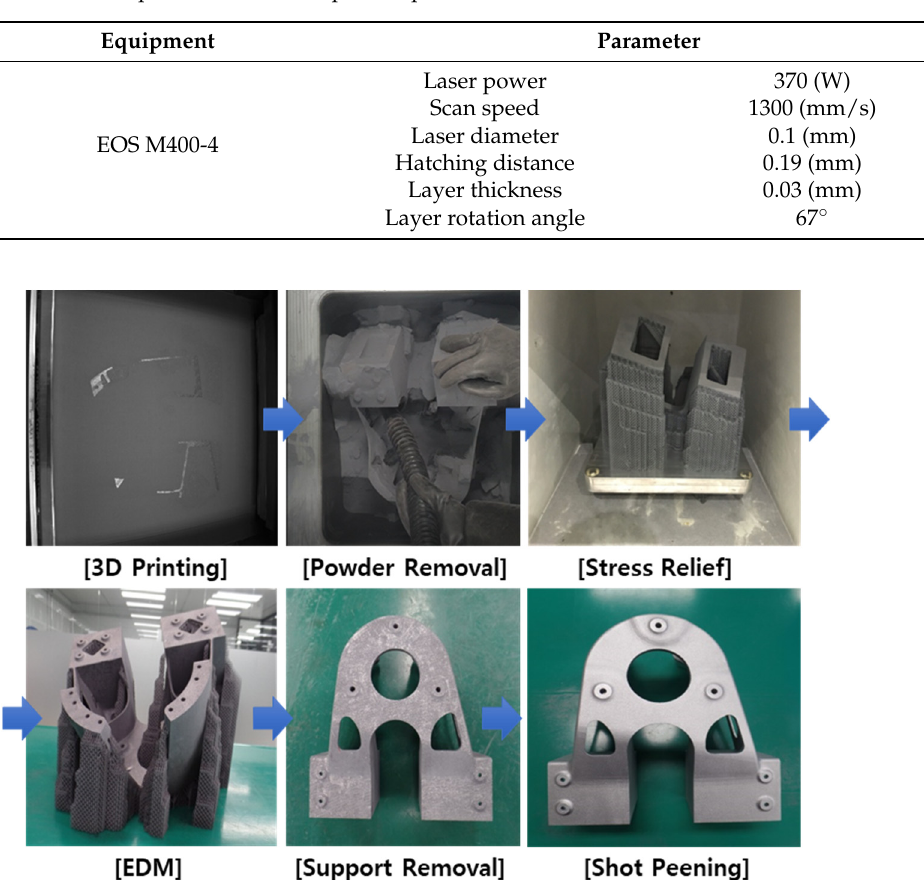
Figure 5. Optimally designed shock absorber node part. Table 1. Laser powder bed fusion process parameters. Table 1. Laser powder bed fusion process parameters.